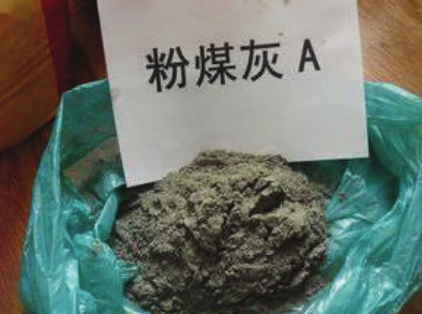
Figure 4: Fly-ash powder.